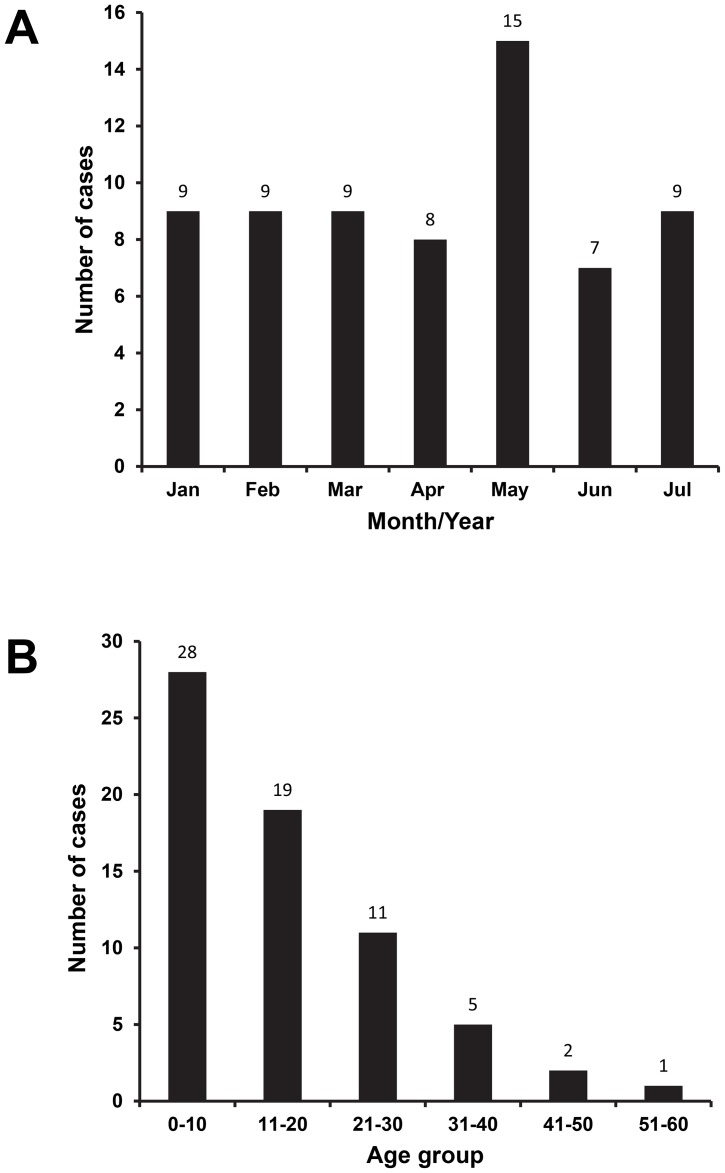
Dengue cases monthly distribution (A) and patients' age (B).All serologically positive dengue patients were grouped according to their hospital admission date and ages.